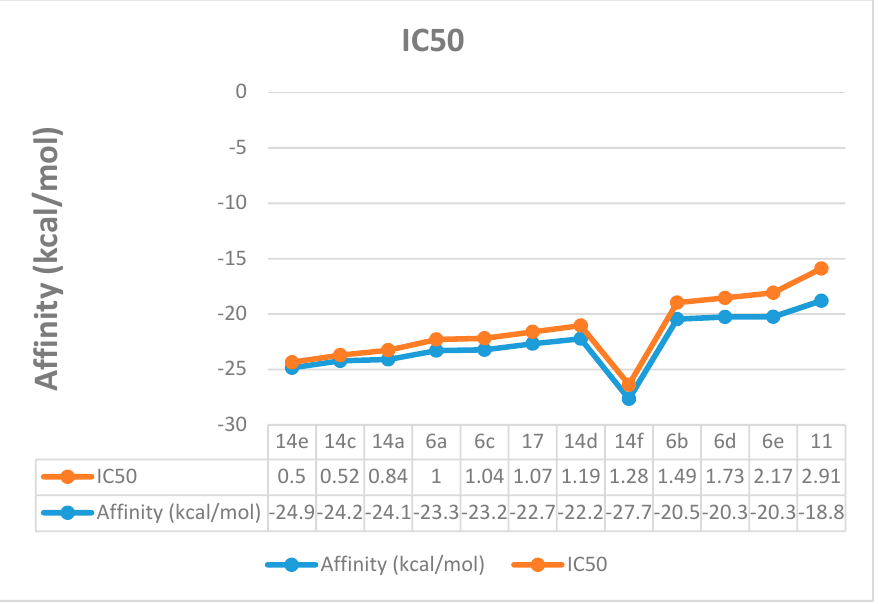
Figure 6. Correlation between the docking affinity and the IC 50 . Table 2. Docking Results of the active compounds using Leadit 2.1.5 software (software license was purchased from BioSolveIT GmbH, Germany).